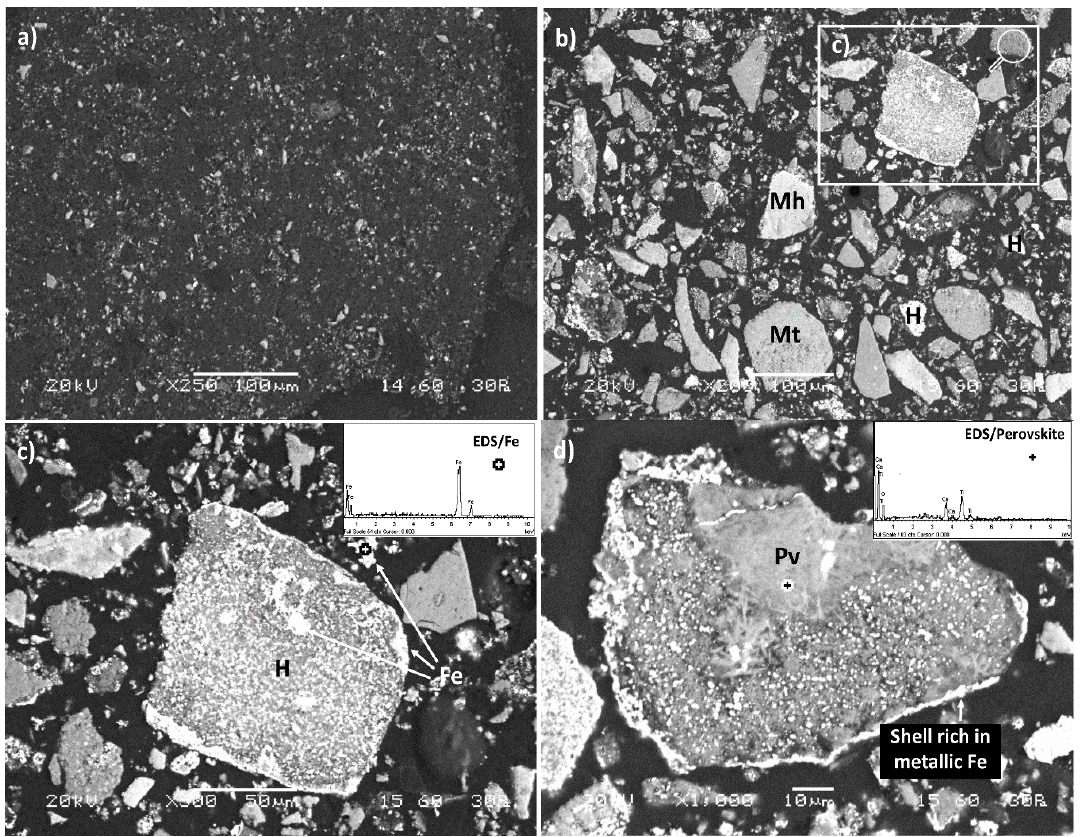
Figure 19. Cross sectional SEM-BSE images of polished surfaces of ( a ) non-magnetic product NMI and ( b – d ) magnetic product MIII obtained after reduction roasting followed by magnetic separation when carbon to bauxite (C / B) ratio was 0.15. EDS spectra obtained in several spot locations show the presence of newly formed metallic oxides (H: Hematite; Mt: Magnetite; Mh: Maghemite; Fe: Metallic iron; Pv: Perovskite).